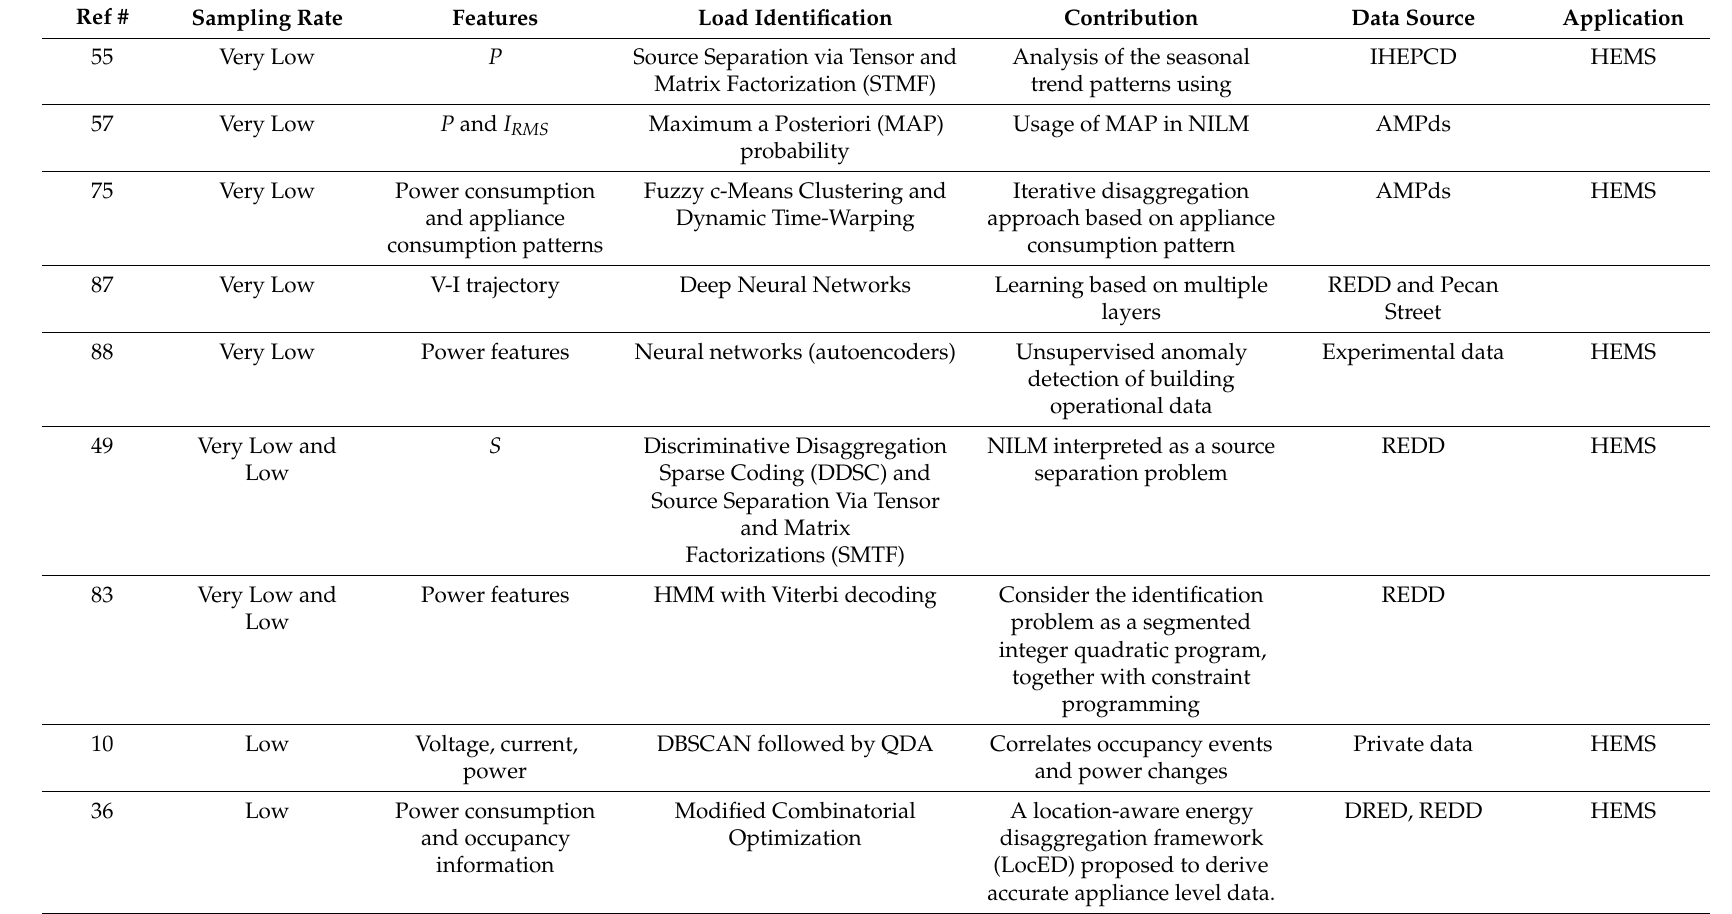
Table A1. Main characteristics of selected NILM techniques with very low, low and medium sampling